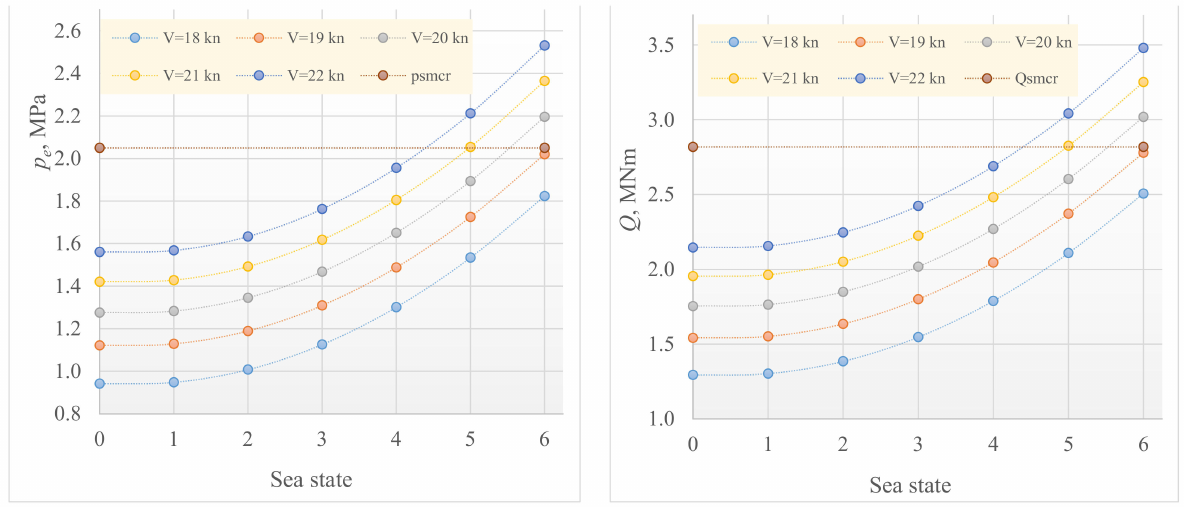
Figure 8. Mean effective pressure ( left ) and required engine torque ( right ) for different sailing speeds and sea